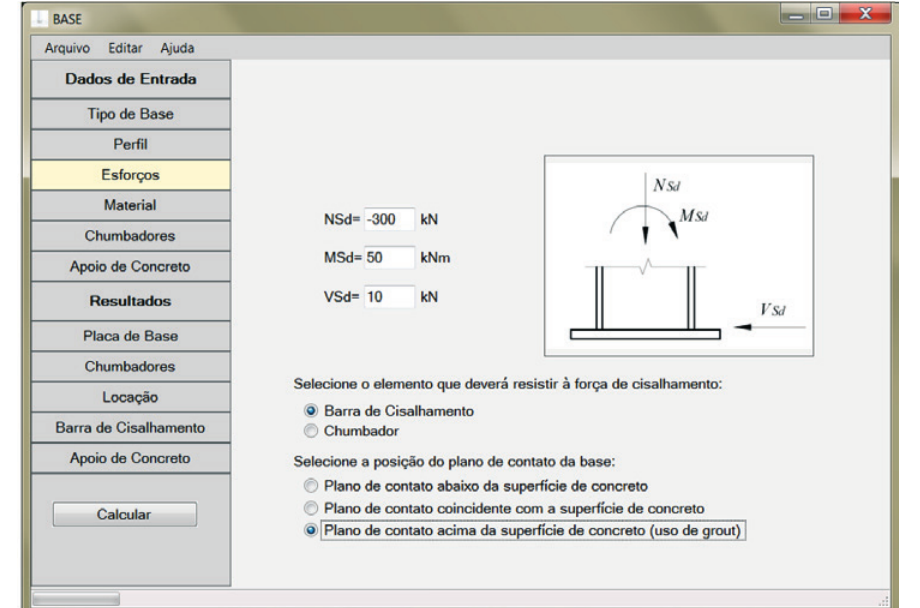
Figura 13 Janela de dados de entrada de apoio de